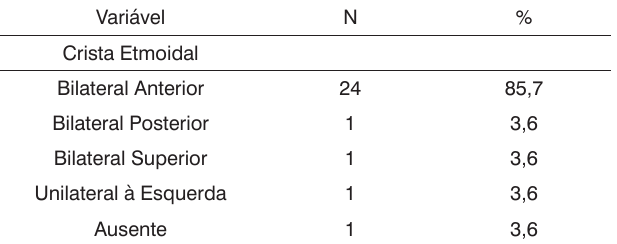
Tabela 2. Distribuição em valores absolutos e percentuais da localização da Crista Etmoidal da lâmina perpendicular do osso palatino.